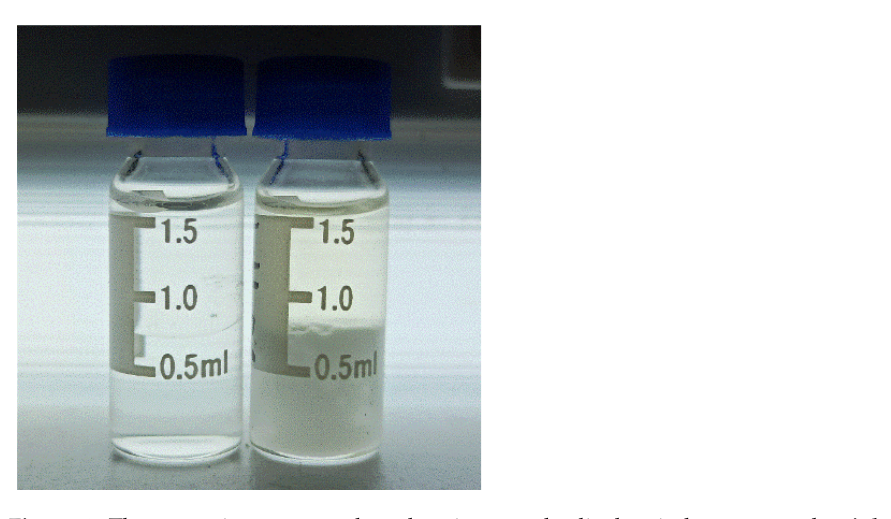
Figure 4. The extraction systems: based on isopropyl salicylate in heptane on the right and with addition of TOPO on the left.